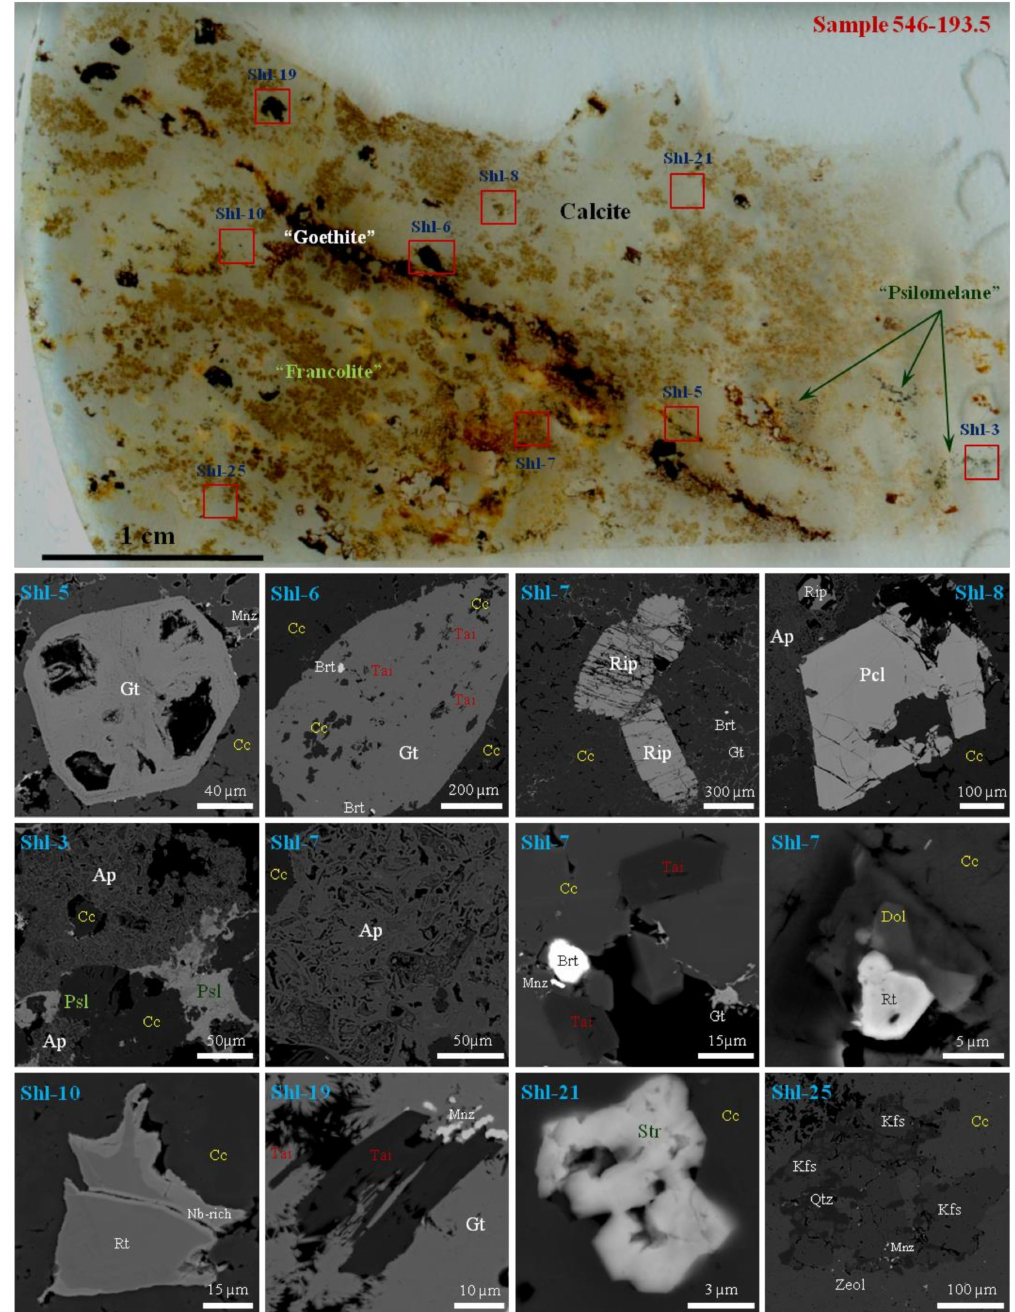
Figure 2. General view and mineral relations for calciocarbonatite from the Chuktukon massif (holotype sample for rippite, 546–193.5), ordinary light and back-scattered electron (BSE) images. Symbols: “Goethite”, Gt—aggregate of goethite and other Fe-oxy / hydroxides; “Francolite”,